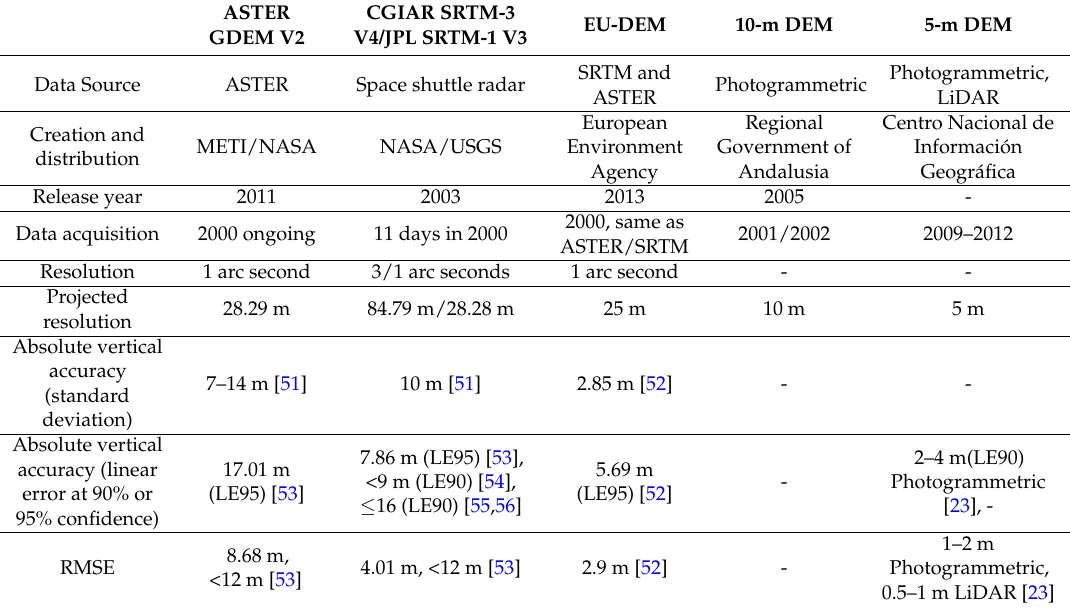
Table 1. Basic information about the applied DEMs [21–23,51–56].